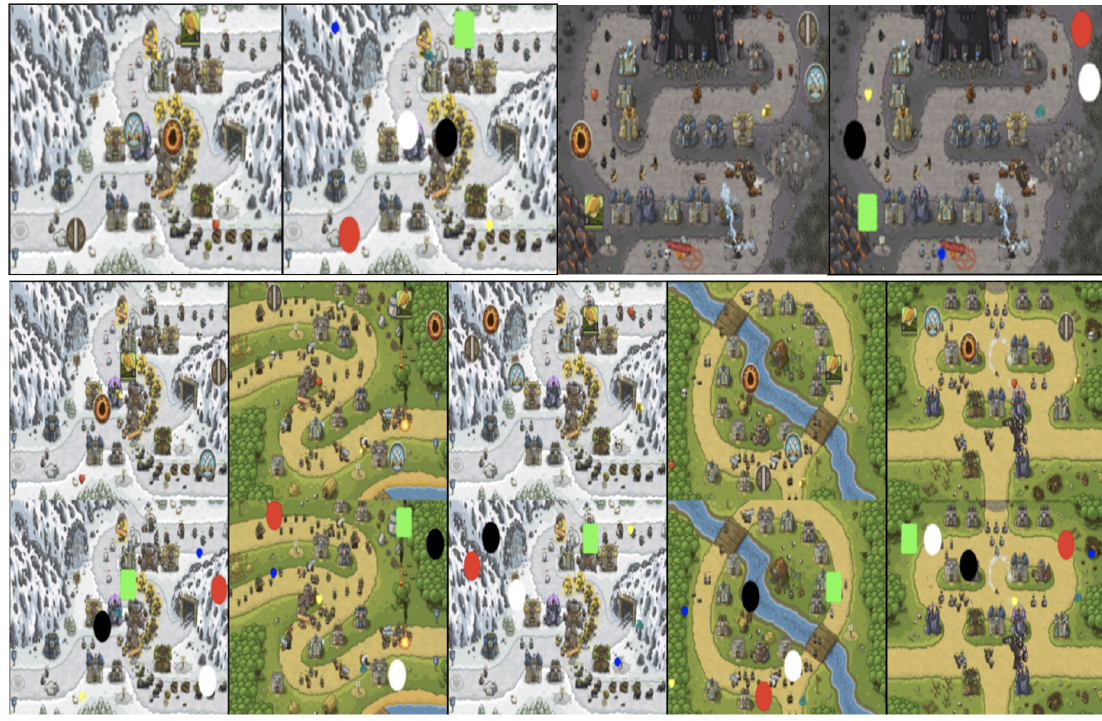
Figure 9. Result of Kingdom Rush UI